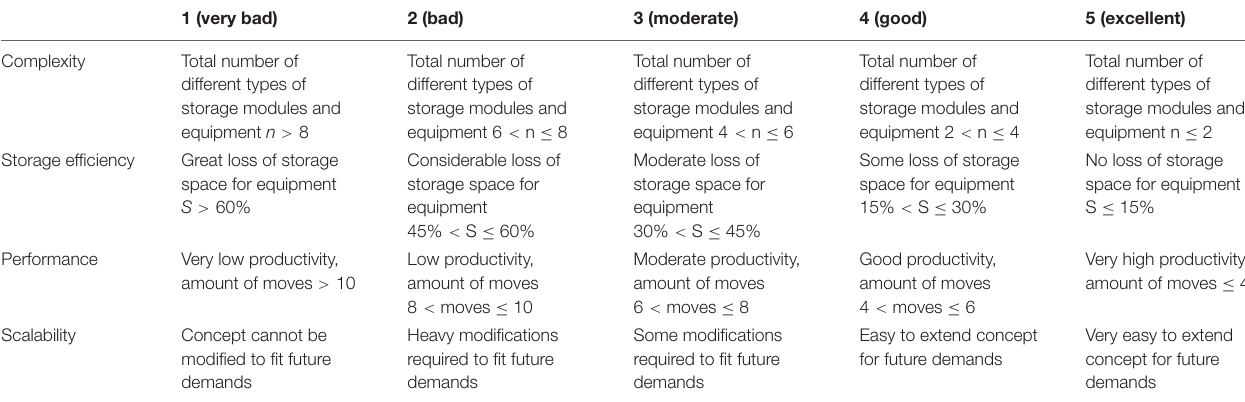
TABLE 4 | Concept review table.